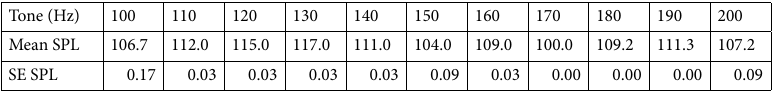
Table 2. SPL (in dB re 1 µPa) of Transfer 2 tones at grid point ’i7’ in the experimental